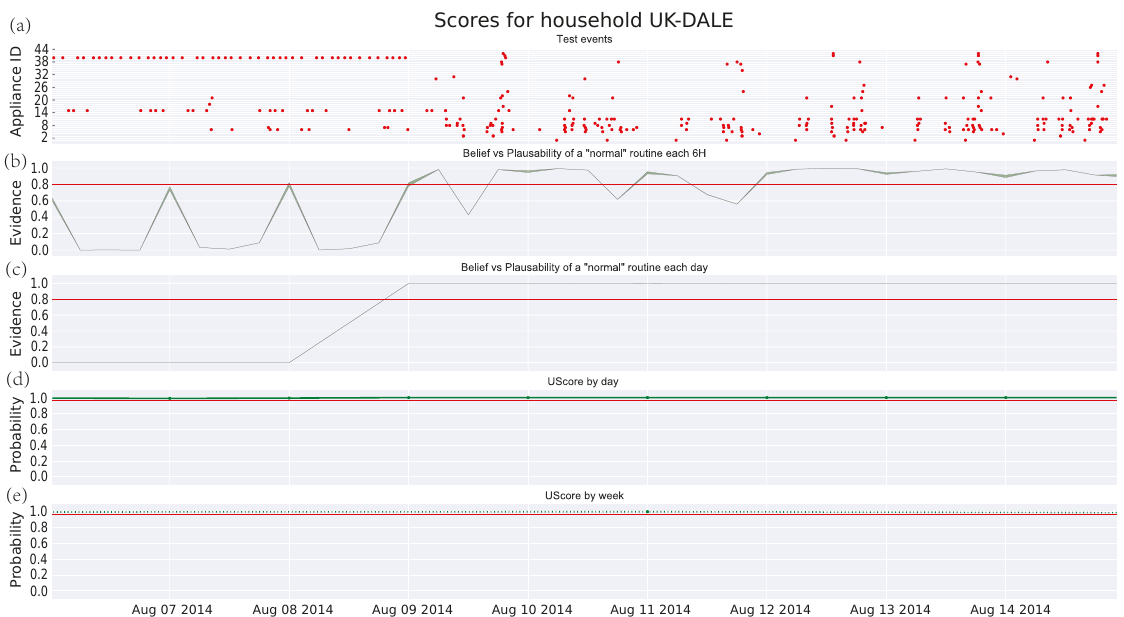
Figure 8. Score for test events in household No. 1 from UKDALE dataset: ( a ) test events; ( b ) DST score every 6 h; ( c ) DST score by day; ( d ) union probability score by day; and ( e ) union probability score by